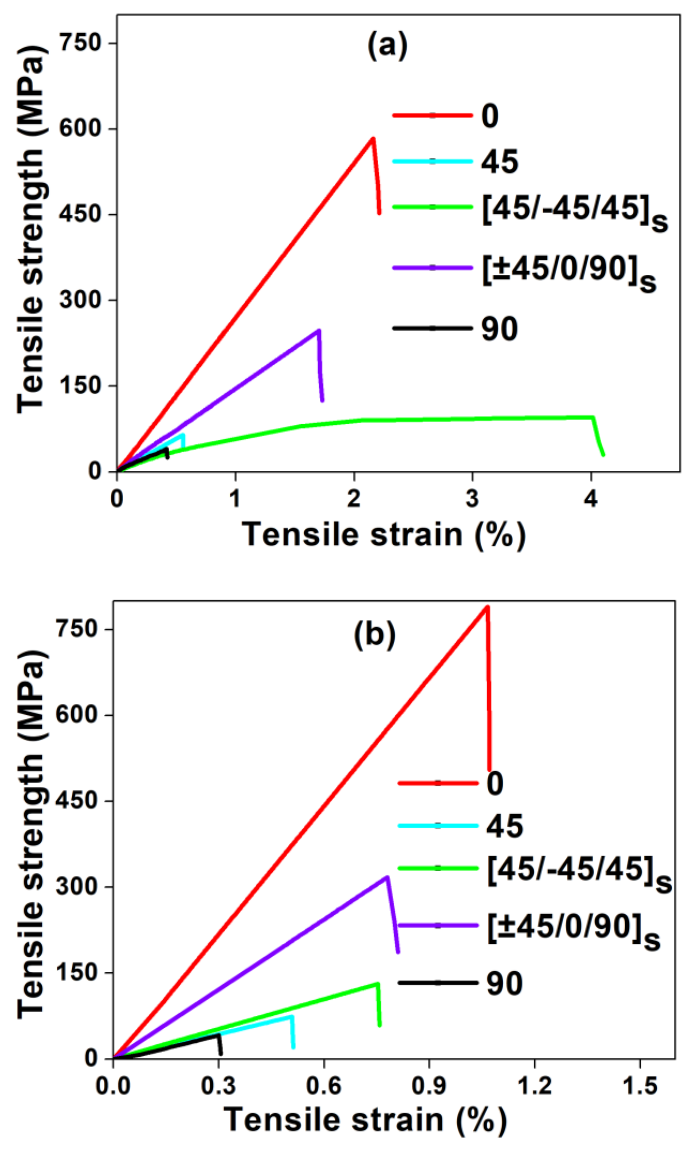
Figure 4. Tensile stress-strain curves of composites: ( a ) GFRP and ( b ) CFRP.